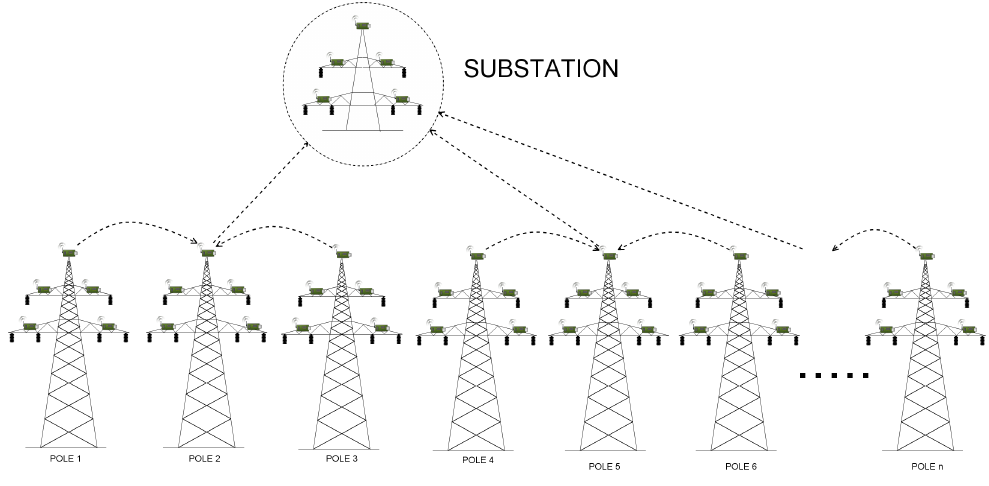
Figure 6. WSN architecture deployed on the example transmission grid, where η =